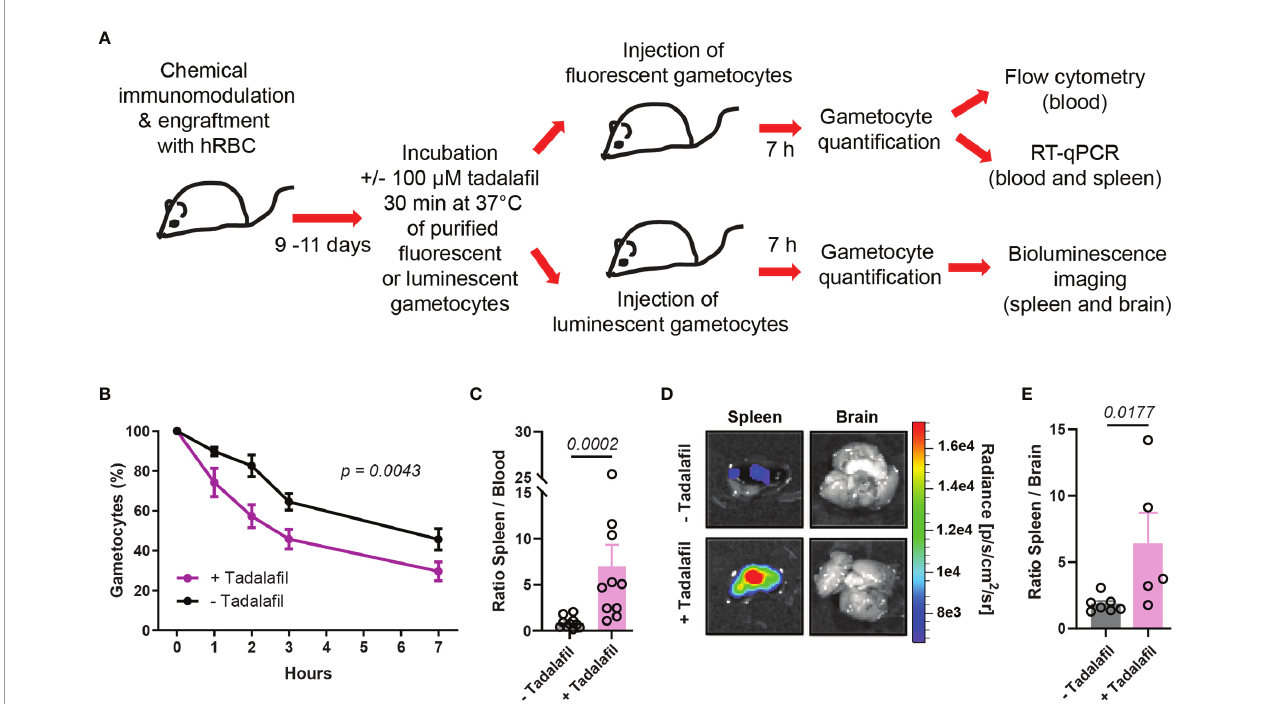
FIGURE 3 | Pre-incubation of mature GIE with tadala fi l induces their retention in the spleen. (A) Schematic of experimental procedure for immunomodulation treatment and hRBC engraftment of NSG mice before injection with tadala fi l-treated or untreated GIE. Stage V GIE were pre-incubated or not 30 min at 37°C with 100 µM tadala fi l before injection in mice. At 7 hpi, quanti fi cation of fl uorescent GIE was performed by fl ow cytometry and RT-qPCR while quanti fi cation of luciferase- expressing GIE in spleen was performed by measuring the bioluminescence signal. (B) Quanti fi cation of GIE clearance in peripheral blood by fl ow cytometry (n = 10 mice from 5 independent experiments). The percentage of gametocytes is normalized to the gametocytemia at 10 minutes after injection. p indicates the statistical signi fi cance determined using a two-way ANOVA test. (C) Quantitative analysis by real time RT-qPCR of GIE distribution in peripheral blood and spleen. Results were calculated as relative copy number of gfp or turbofp635 gene transcripts to the HK gene transcripts in spleen and blood samples. The graph represents the ratio spleen-to-blood for 10 mice from 5 independent experiments. (D) Representative image of luminescence signal in dissected spleen and brain from mice injected with tadala fi l-treated and untreated GIE. The brain was used as negative control. (E) Quanti fi cation of luciferase activity calculated as the ratio of radiance in spleen and brain from mice injected with tadala fi l-treated and untreated GIE. Circles indicate the number of mice from 5 independent experiments for untreated GIE and from 4 independent experiments for tadala fi l-treated GIE. In C and E, p indicates the statistical signi fi cance determined using a Mann Whitney test. Error bars show the standard error of the mean